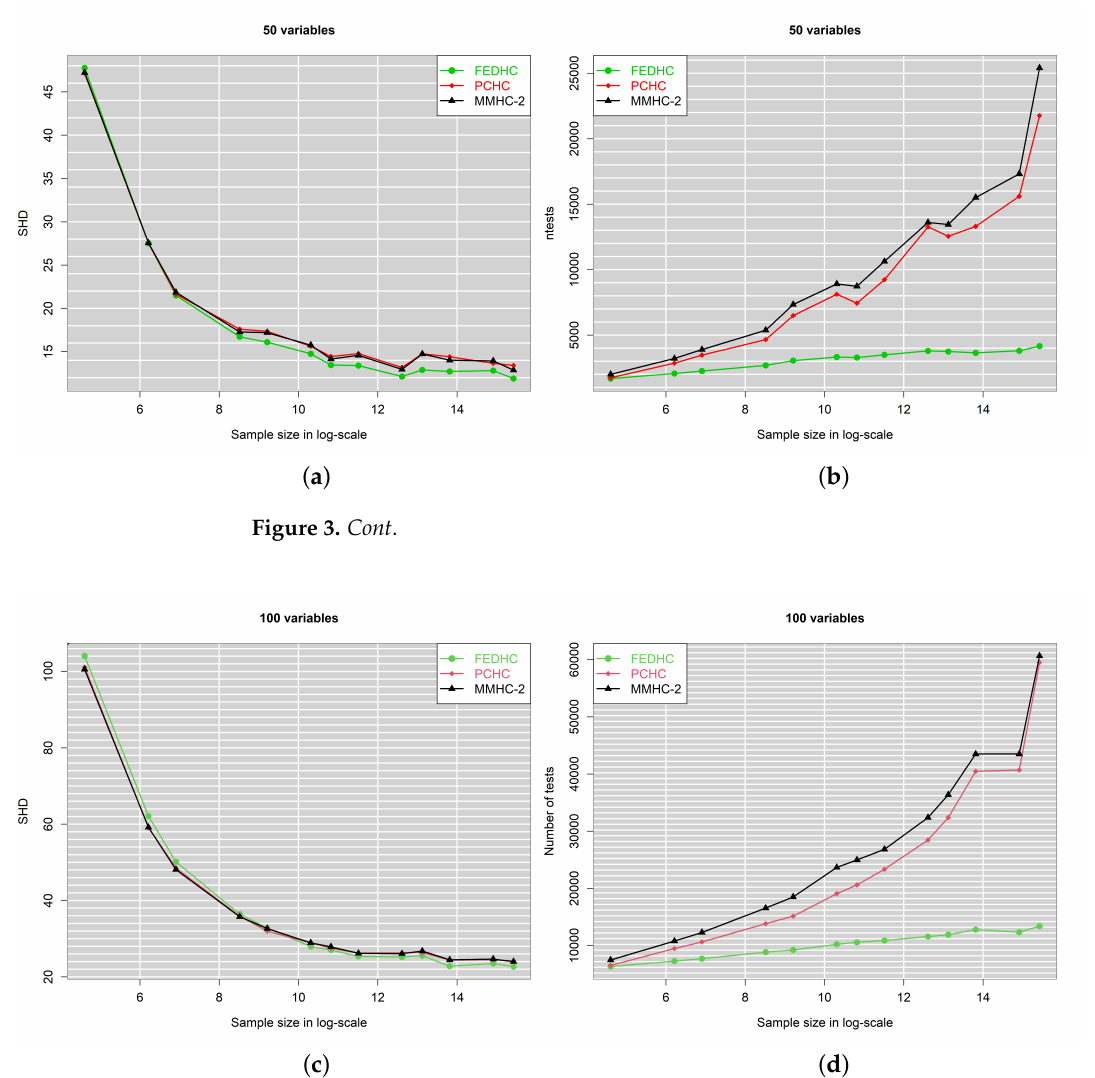
Figure 3. SHD and number of CI tests against log of sample size for 50 and 100 dimensions, with 3neighbours on average. ( a ) SHD vs. log of sample size. ( b ) Number of CI tests vs. log of sample size. ( c ) SHD vs. log of sample size. ( d ) Number of CI tests vs. log of sample